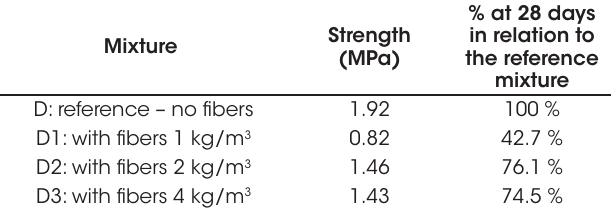
Split tensile strength after the addition of fibers at 28 days